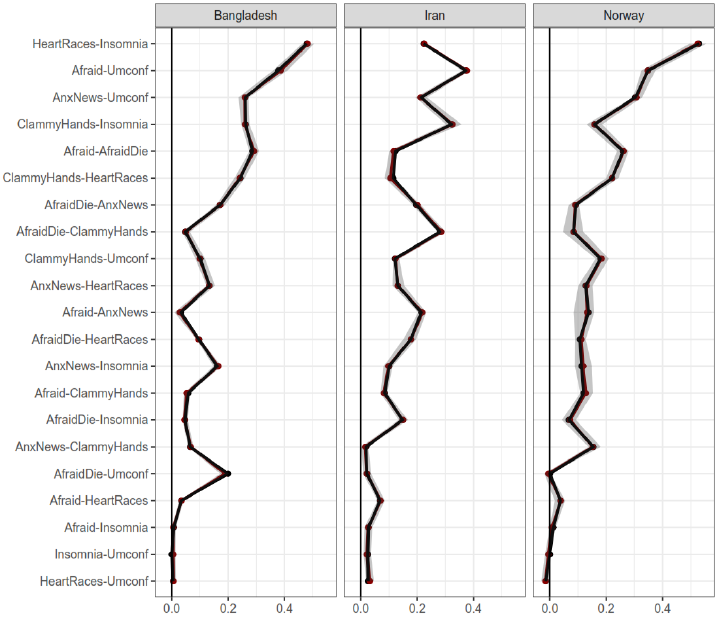
Figure 6. Bootstrapped edges for networks of Iran, Bangladesh, and Norway. Note: Horizontal axis represents edge weight. Shaded regions represent 95% confidence intervals for the measures.